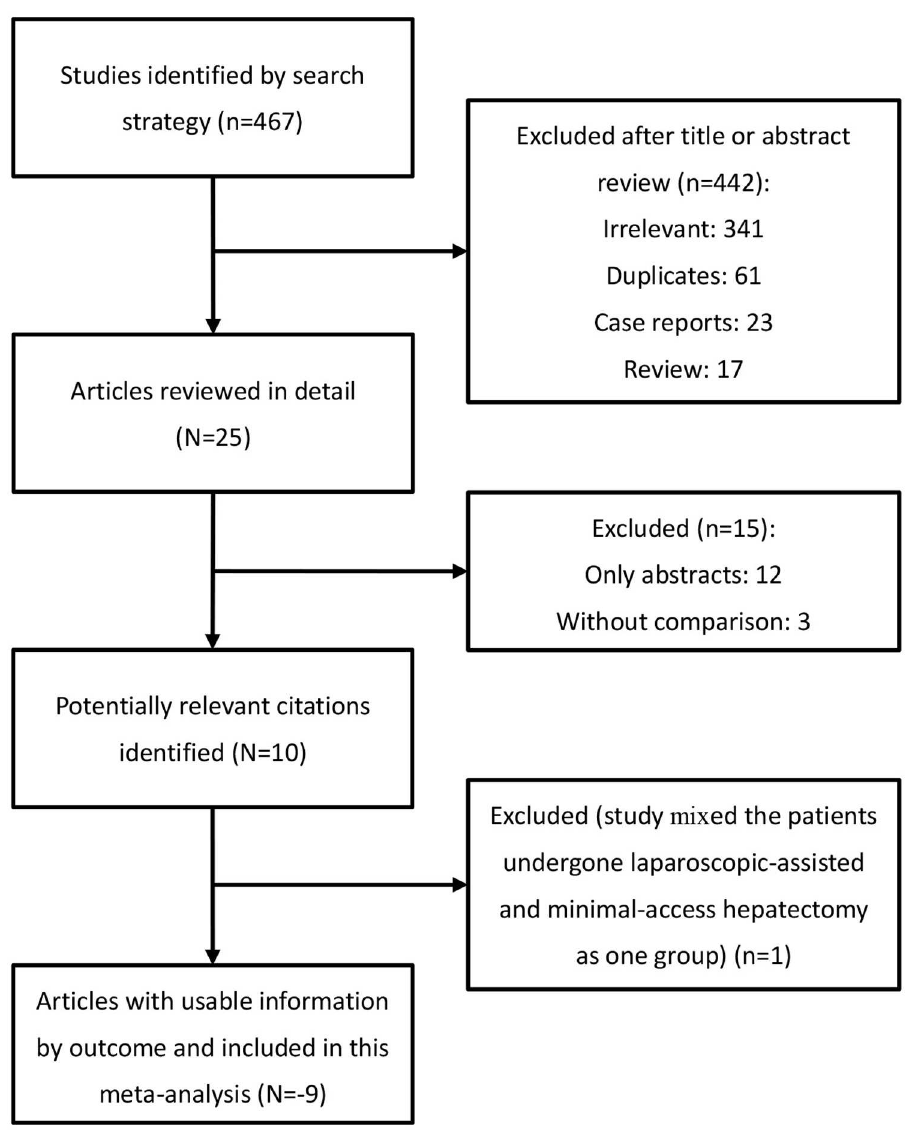
Fig 1. Selection flow